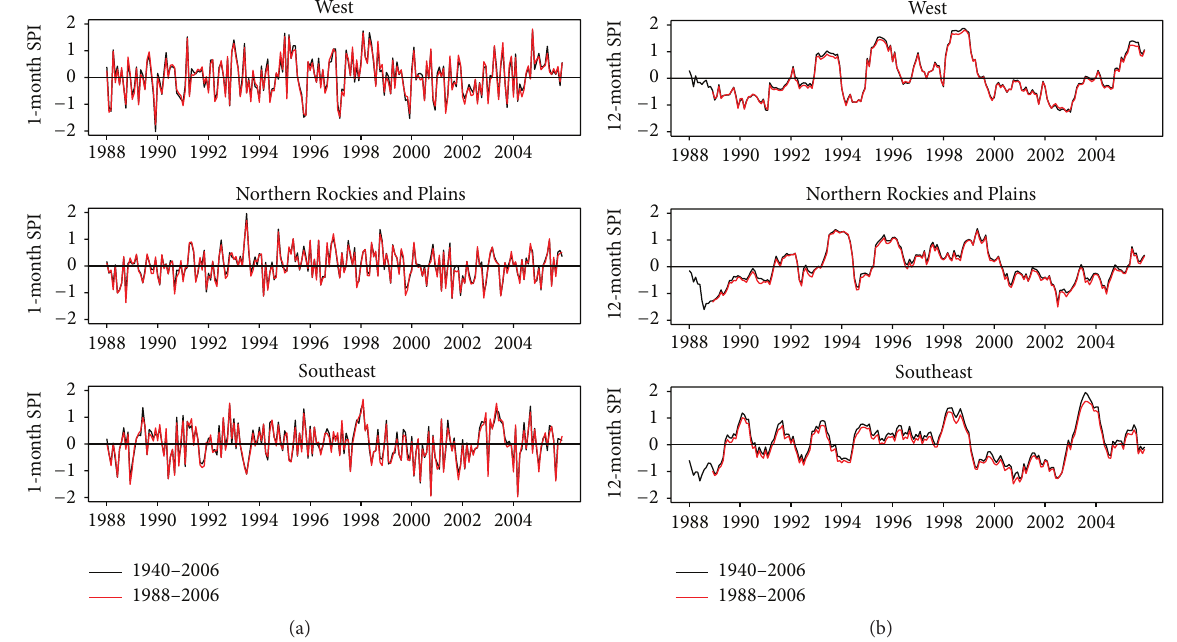
Figure 2: One-month (a) and 12-month (b) accumulated SPI values computed using PRISM climatological records of 1940–2006 (“long record,” black) and 1988–2006 (“short record,”